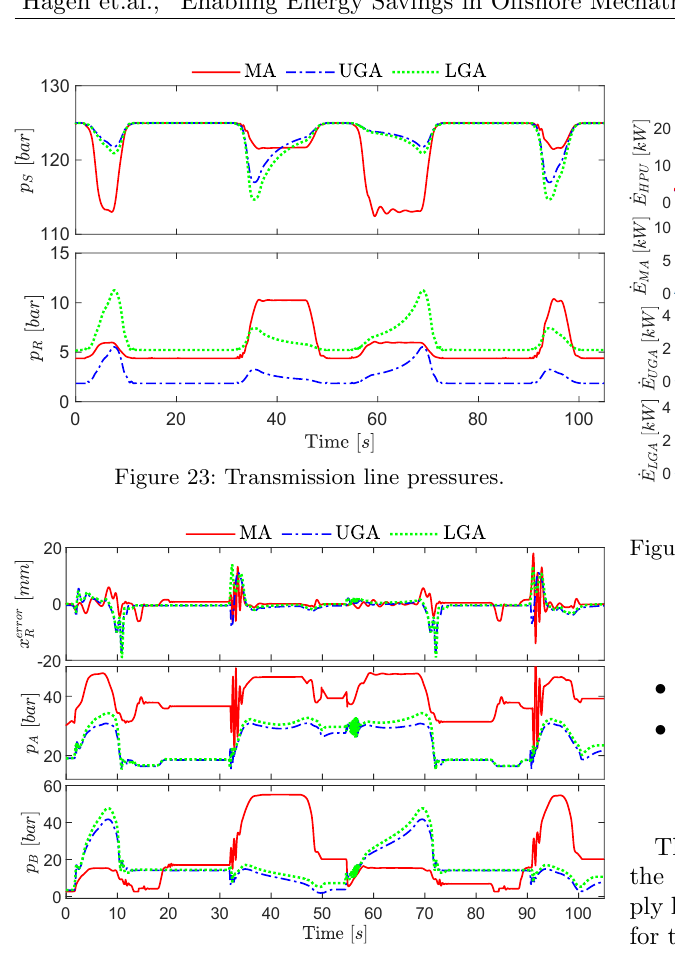
Figure 24: Reach arms performance.